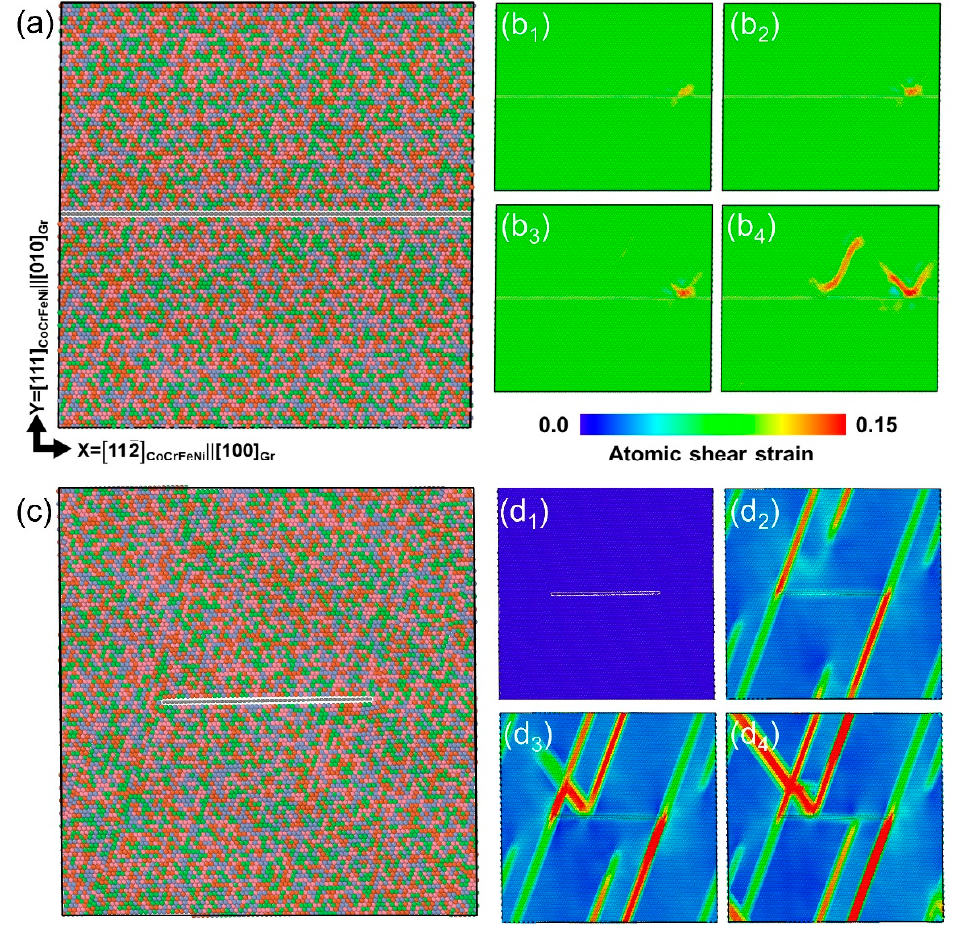
Figure 6. ( a ) The CoCrFeNi/graphene/CoCrFeNi atomic configuration; ( b1 – b4 ) the corresponding atomic shear strain maps at the compressive strain of 16.0, 16.1, 16.2, and 16.4%; ( c ) the CoCrFeNi/intermittent graphene/CoCrFeNi atomic configuration; ( d1 – d4 ) the corresponding atomic shear strain maps at the compressive strain of 0, 5.4, 5.6, and 6.0%.